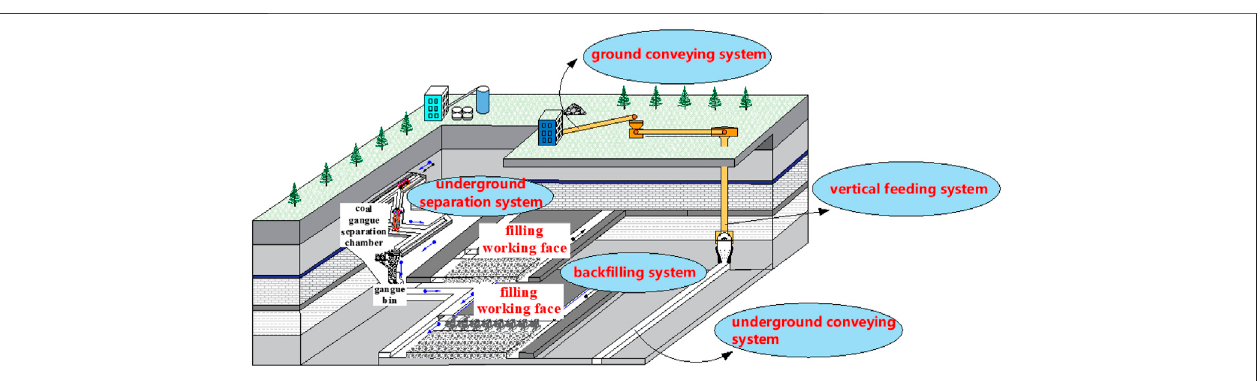
FIGURE 2 | Back fi lling system of Tangshan Mine (Zhang et al., 2015).